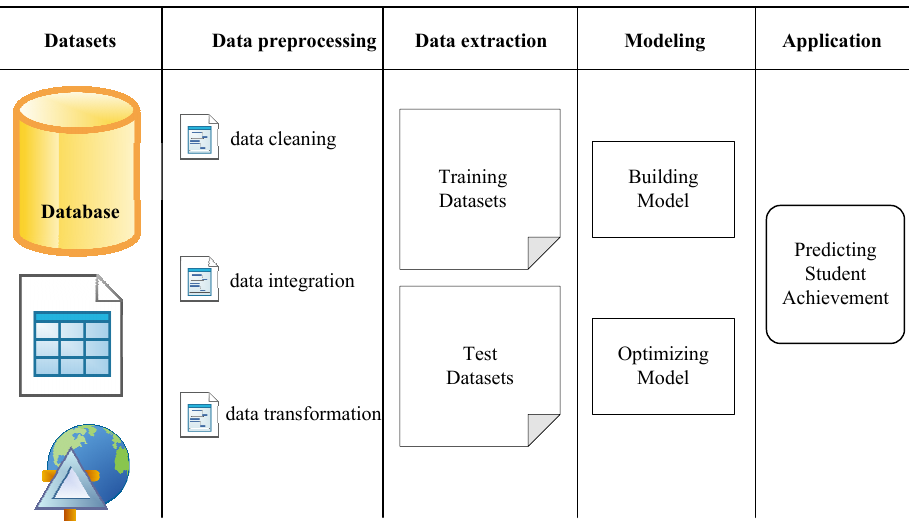
Figure 1. Student achievement prediction process